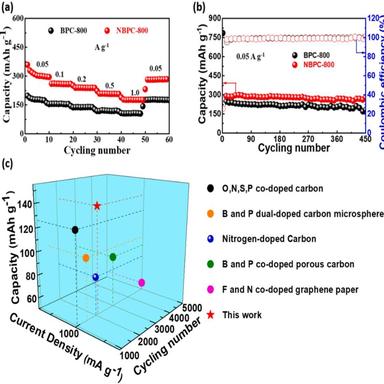
(a) Rate performances of BPC-800 and NBPC-800 at different current densities from 0.05 to 1 A/g. (b) Cycling performances of BPC-800 and NBPC-800 at a current density of 0.05 A/g. (c) Comparison of electrochemical performances between the NBPC and other reported doped-carbon anodes for SIBs.